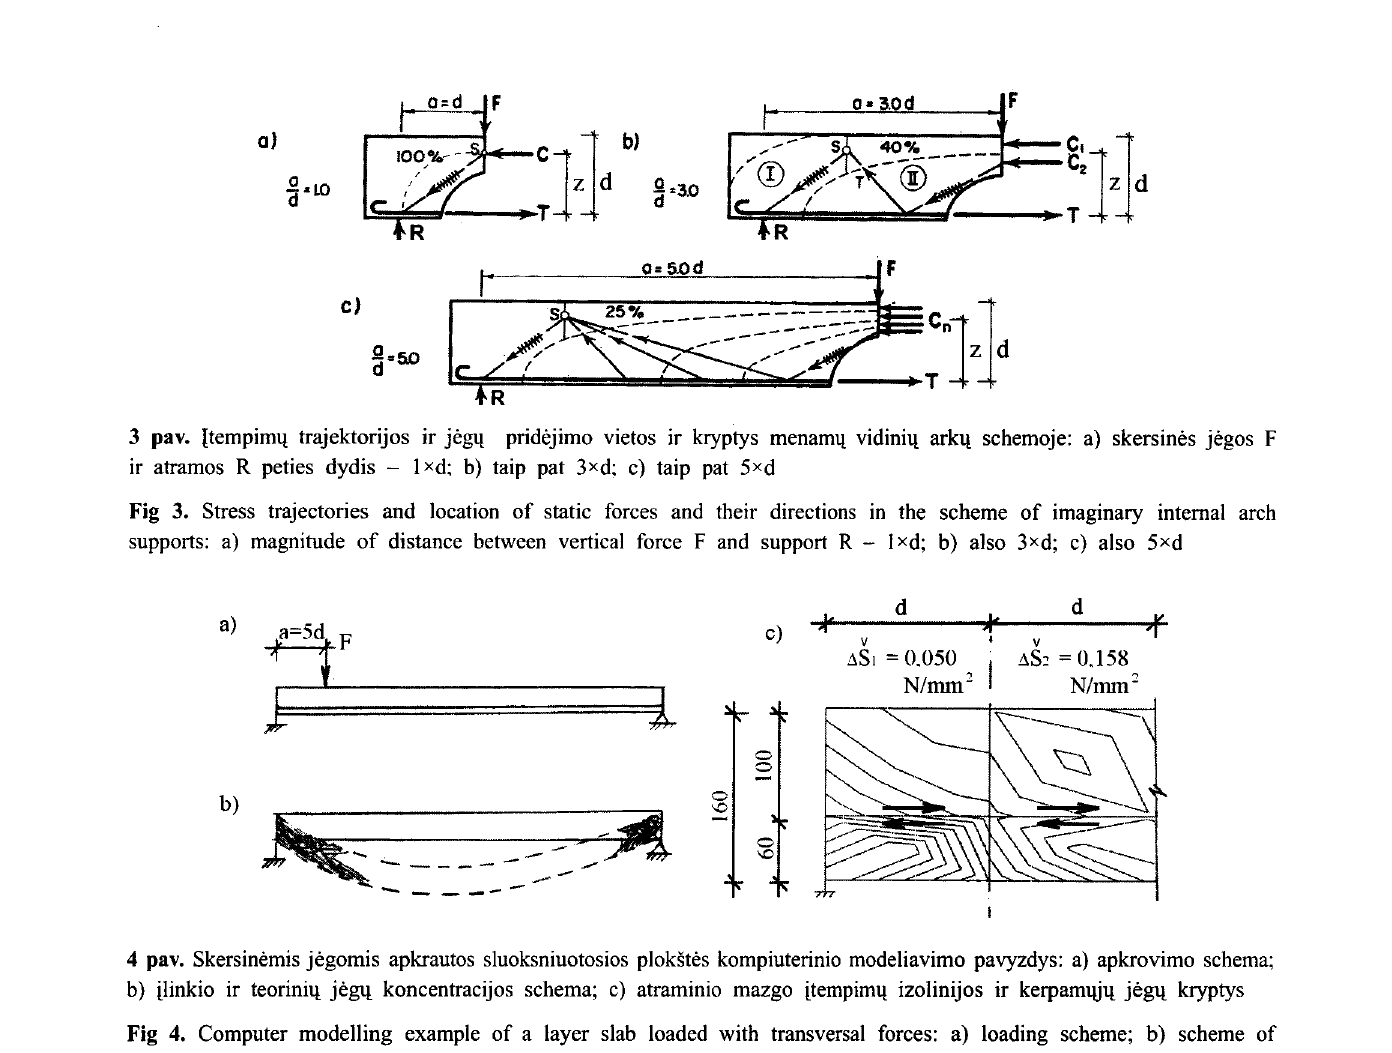
Fig 4. Computer modelling example of a layer slab loaded with transversal forces: a) loading scheme; b) scheme of deflection and concentration of theoretical forces; c) stress isolines of the support